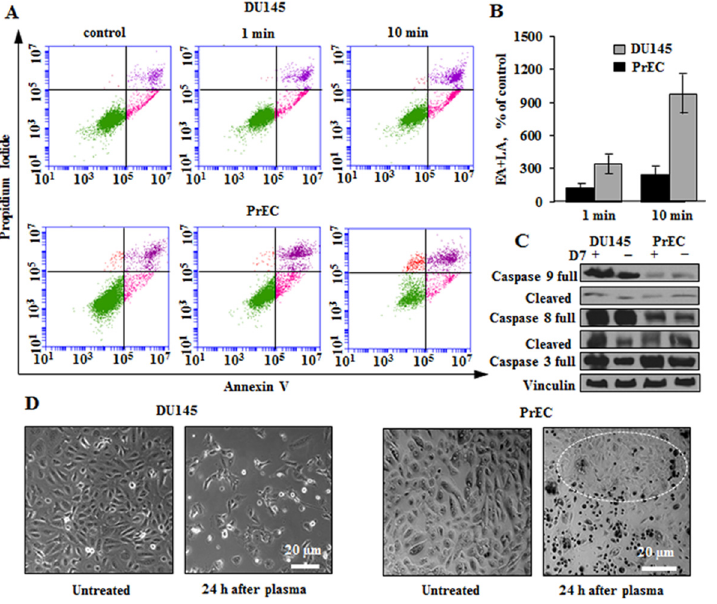
Fig 2. Non-thermal plasma induces apoptosis in DU145 cancer and PrEC normal prostate cells. Flow cytometry and microscopy results were obtained 24 hours post plasma treatment. ( A ) Induction of apoptosis in DU145 and PrECs. The cells were incubated with plasma D7 for 1 and 10 minutes than fresh medium was added to cells for their further maintaining. ( B ) The quantitative data of the per cent of early and late (EA+LA) apoptotic cells. C. Western blot analysis of apoptosis signature. Vinculin was used as a loading control. ( D ) Transmission images of normal PrEC and metastatic DU145 cells. The white circle indicates the area of PrECs that remained alive or proliferated after the plasma treatment. Data presented as mean ± SEM (n = 3).